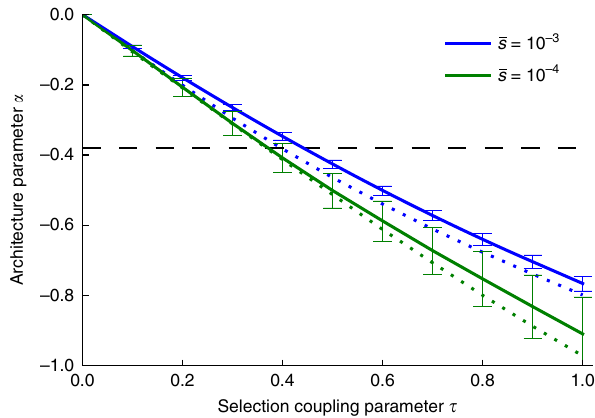
Fig. 3 Value of α as a function of τ and other parameters in forward simulations. We report best- fi t α estimates for simulations at each value of τ at a given genome-wide average selection coef fi cient (cid:2) s . Selection coef fi cients were sampled using a gamma distribution shape parameter of k = 0.25 (solid lines) or k = 0.125 (dotted lines). α estimates where calculated by fi tting the model in Eq. (1) to simulated SNP effects above twice the MAF threshold 2 T ¼ k (in order to avoid edge effects near T ), 2 N e (cid:2) s with error bars representing standard errors calculated by bootstrap resampling of 25 independent SLiM2 simulations. The horizontal dashed line indicates α = − 0.38, the best- fi t α across the 25 UK Biobank traits. Results for a broader range of k values are reported in Supplementary Figure 5. Source data are provided as a Source Data fi